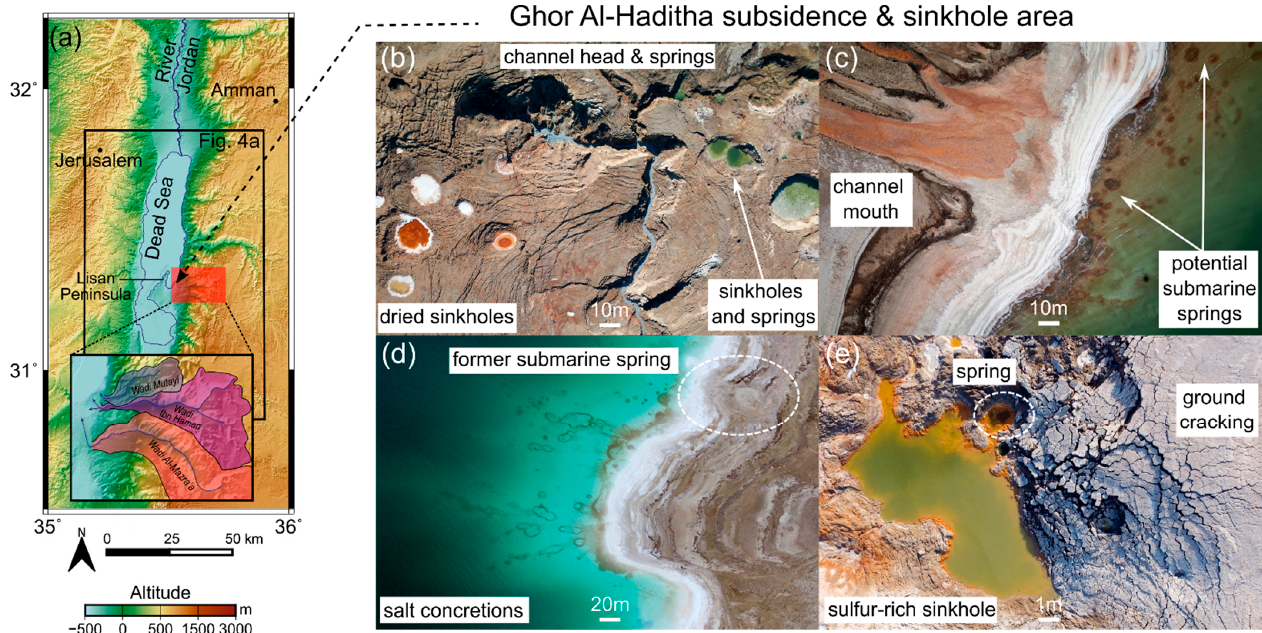
Figure 1. ( a ) Overview map of the Dead Sea with the location of the highlight area, wadi surroundings (inset) and aerial images of fluid escape structures: ( b ) Springs, sinkholes and head incision at the channel/spring system called “CM5”. ( c ) Channel mouth development and submarine features.